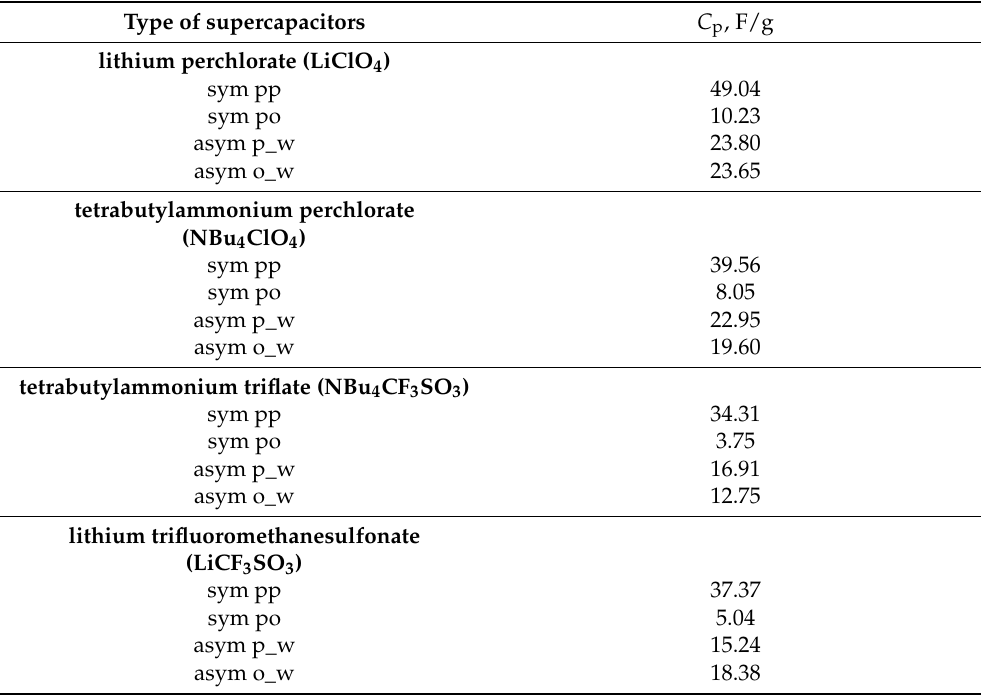
Table 1. The results of the specific capacitance C p of the tested supercapacitors.